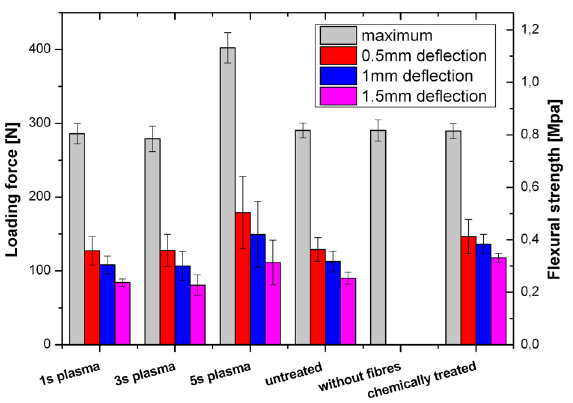
Figure 9: The results of three point bending test of fibre-reinforced concrete samples without fibres, with chemically treated fibres, non-treated and PP fibres treated in DCSBD with maximum loading before crack and 0.5 mm, 1 mm and 1.5 mm deflection after crack of the samples.